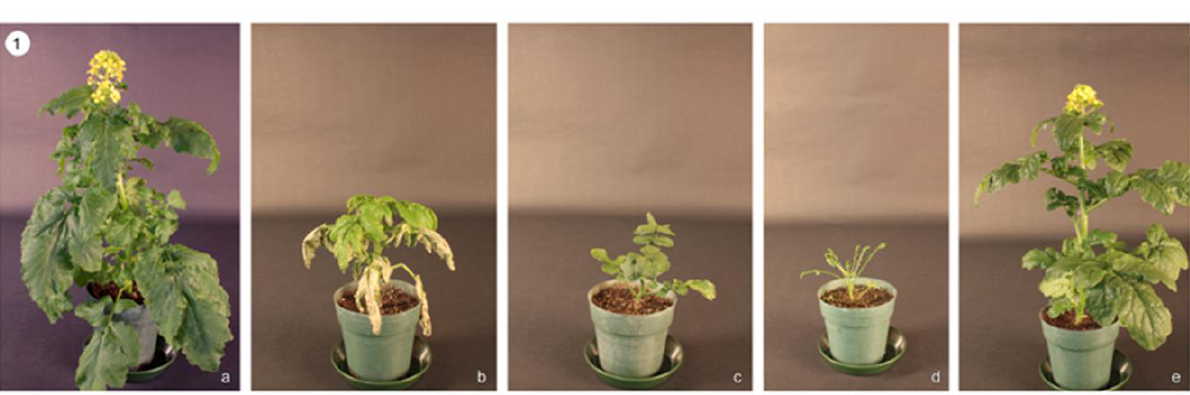
Figure 1. Open-pollinated (S0) and S1 plants of cv. Andante. ( a ) Open-pollinated (S0) plant; ( b ) Abnormal S1 plant with withering leaves; ( c ) Abnormal S1 plant without main inflorescence; ( d ) Weak S1 plant exhibiting reduced leaf size and stunted growth; ( e ) Normal S1